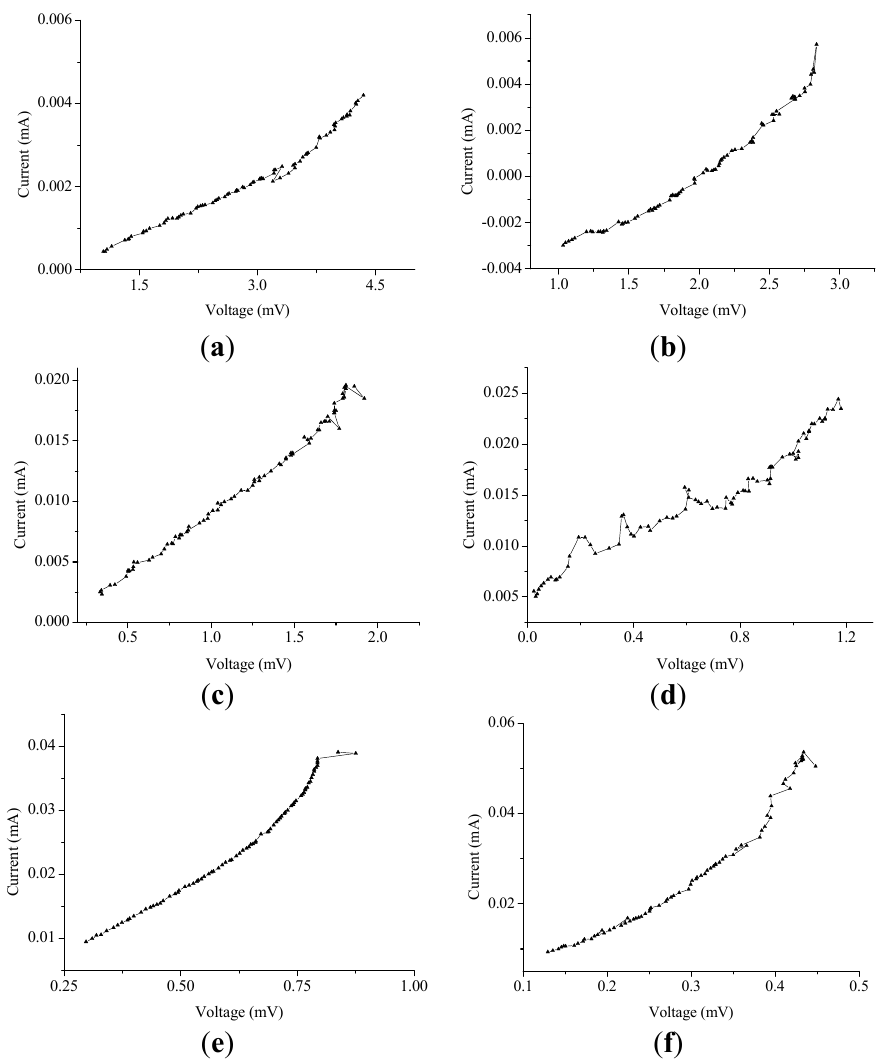
Figure 5. The current vs. voltage characteristics (for 1.2 h) due to ( a ) 0.5; ( b ) 1.0; ( c ) 1.5; ( d ) 2.0; ( e ) 2.5; and ( f ) 3.0